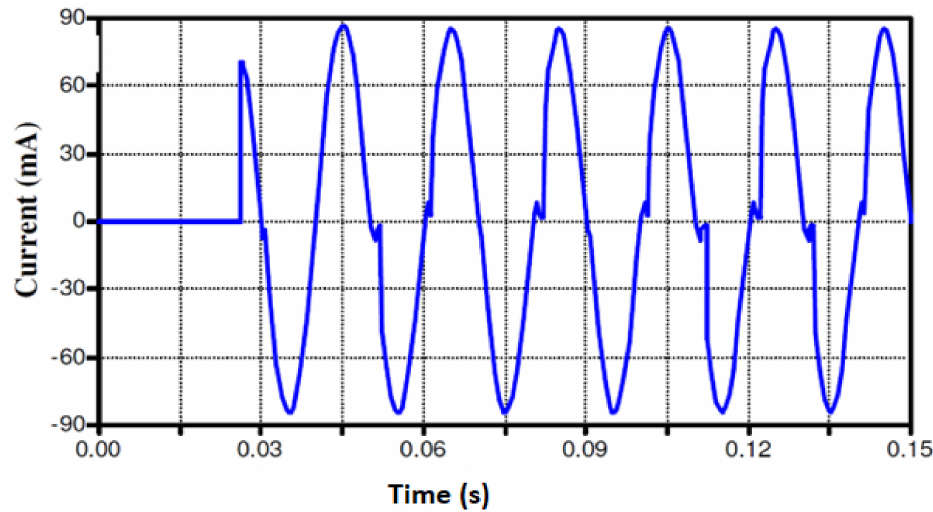
Figure 10. HIF current and voltage